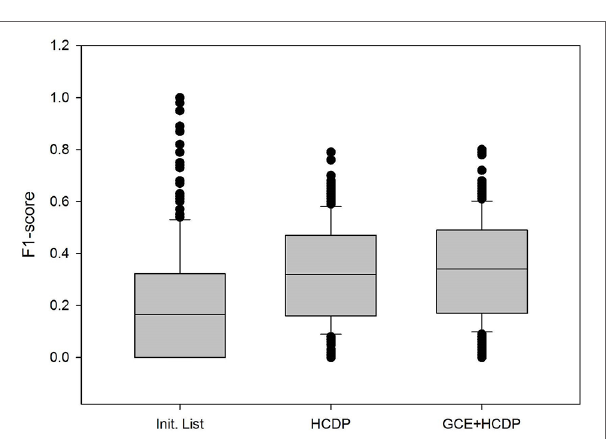
FIGURE 2 | The inclusion of HCDPs filtered by Gene co-expression (GCE- HCDP) to generate extended gene sets led to an overall improved target prioritisation performance when compared with the inclusion of unfiltered HCDPs and un-extended gene sets.